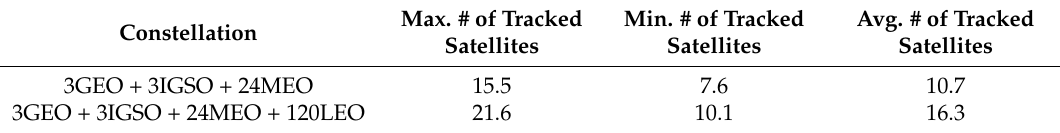
Table 5. Statistical results for satellite visibility.